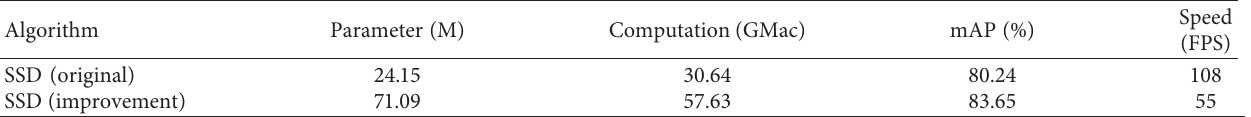
Figure 12: The detection effect of SSD algorithm on unfilled corners and line marks before and after improvement. (a) The detection effect of MobileNetV2-SSD. (b) The detection effect of original SSD. (c) The detection effect of improved SSD. Table 3: Parameter comparison before and after improvement of SSD algorithm.